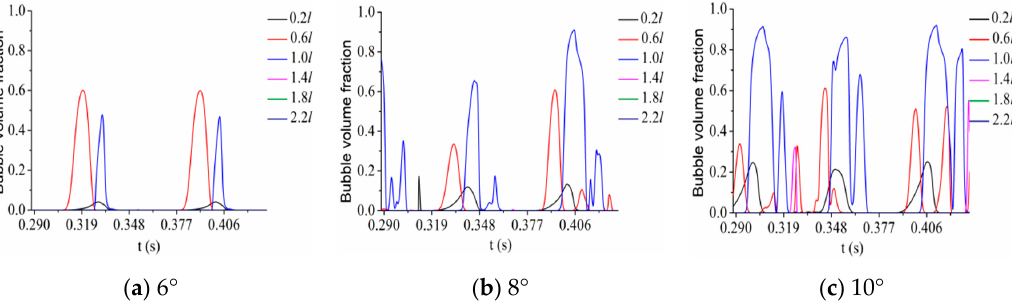
Figure 9. Curve of cavity fraction at monitoring point with different attack angles in two periods.